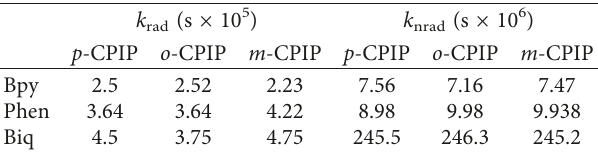
Table 5: Aerated photophysical rates for ruthenium polypyridyl complexes.